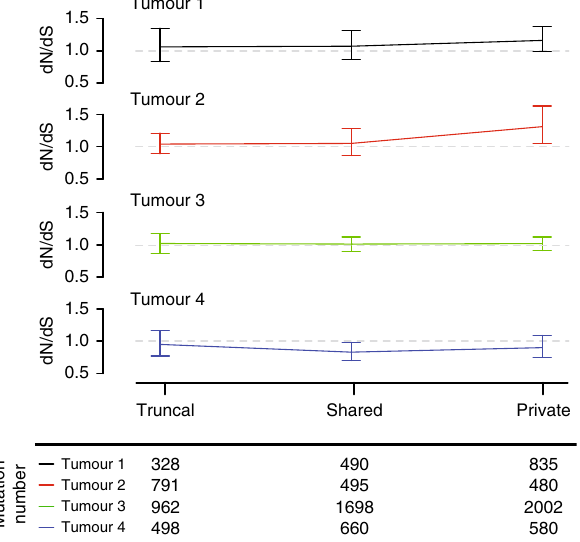
(Fig. 6f, g), con fi rming our MSeq results. A total of 44.0% of